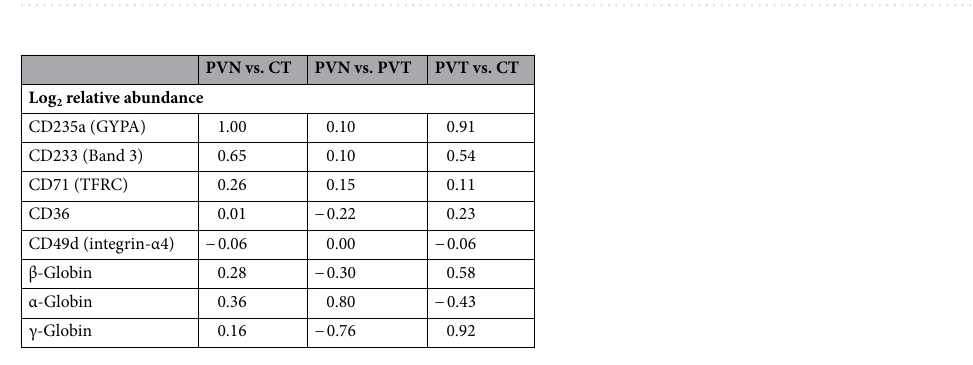
Table 2. Relative abundance (log 2 of fold change) of erythroid proteins in each comparison.